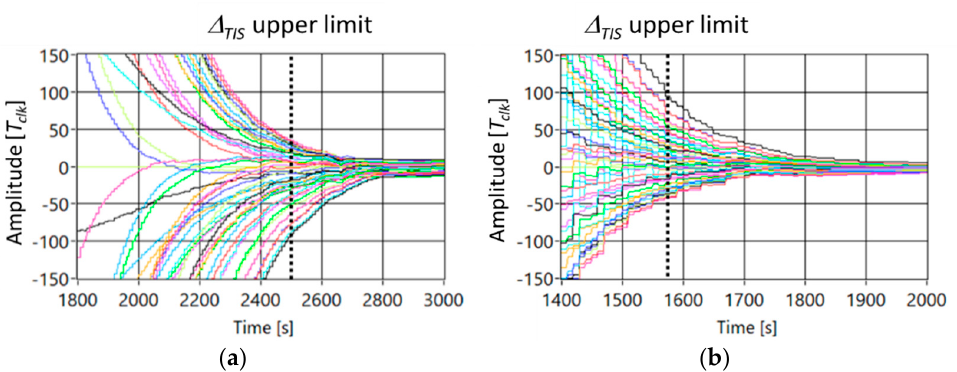
Figure 4. Trend of the delay among nodes in the case Nc = 49 and ( a ) static topology, and ( b ) MSO is moving according to route#4.